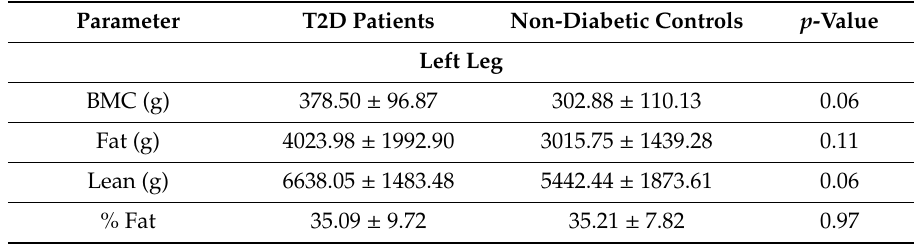
Table 6. Comparison between lower limb body composition between T2D patients and Non-diabetic